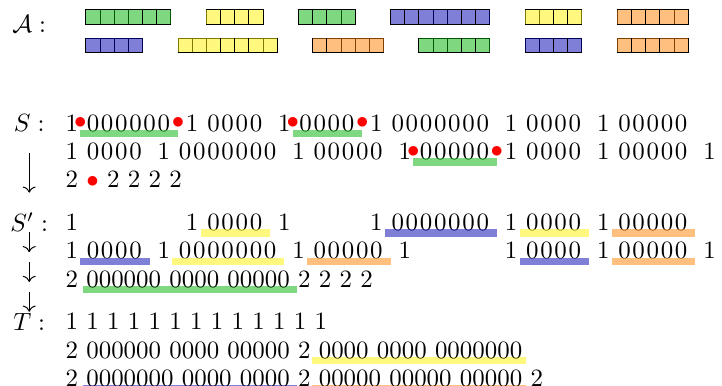
Figure 3. Example of the proposed reduction starting from the following instance of 3-P ARTITION : = 6,4,4,7,4,5,4,7,5,5,4,5 (thus m = 4) and B = 15. Each a i is represented by a rectangle A { } containing a i squares. Colors in describe a way to partition into triplets, each summing to A A B = 15. S and T are built as described in the reduction. Each vertical arrow corresponds to a 7-cut. The first one, which is the first step of the proposed 7-cut rearrangement scenario, going from S to S (cid:48) , is detailed: each red bullet corresponds to a cut, and blocks of 0 that are rearranged are underlined in green (corresponding to the three “green a i s” summing to B